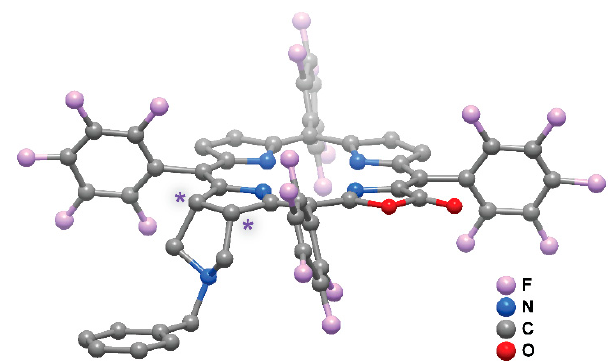
Figure 2. Absorption spectra of compounds 3a , 6a , and 7a in chloroform (c = ~2 × 10 − 6 mol.L − 1 ).